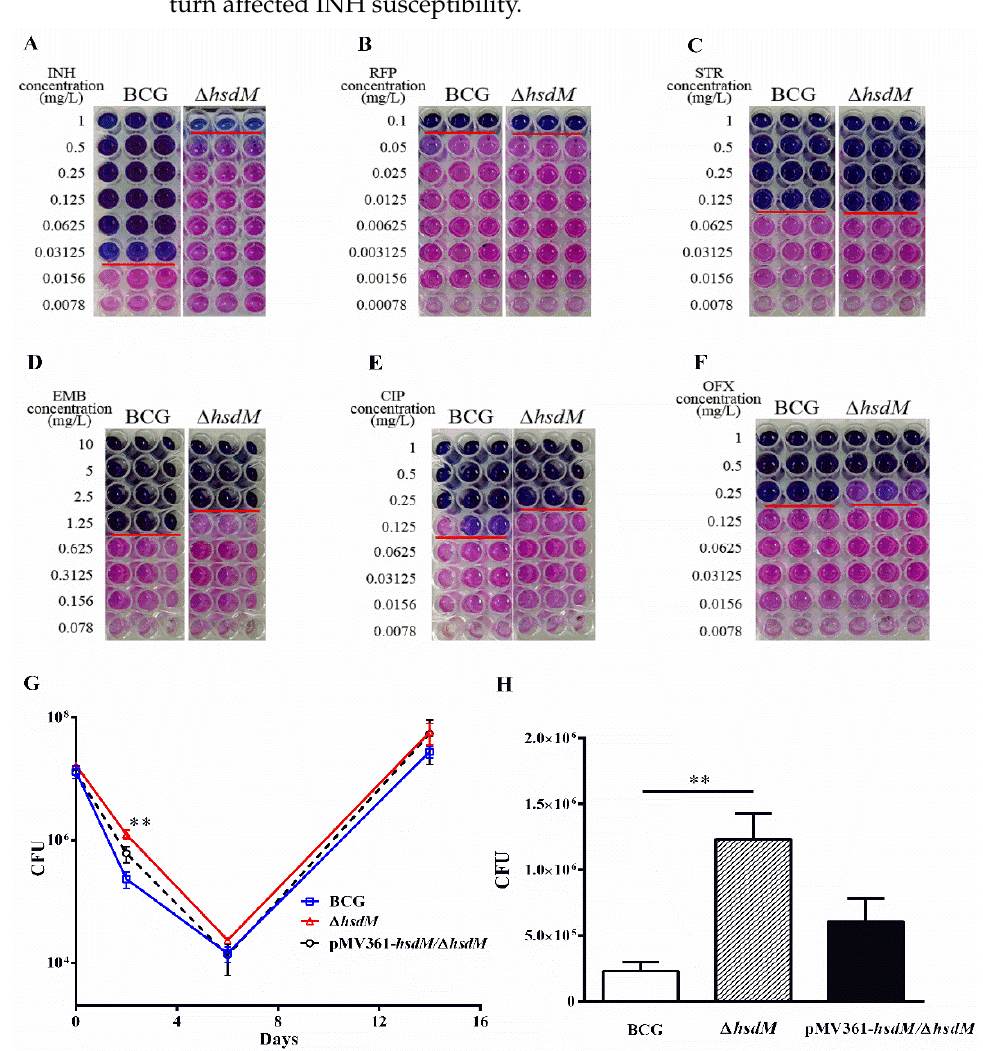
Figure 2. HsdM affected drug susceptibility in BCG. ( A – F ) MICs of INH, RFP, EMB, STR, OFX and CIP on microplates in BCG and ∆ hsdM . Blue wells indicate no growth owing to drug inhibition; pink wells indicate growth. ( G ) Growth curves of BCG, ∆ hsdM and pMV361- hsdM / ∆ hsdM strains treated with 0.25 mg/L INH. ( H ) The number of surviving cells was examined by monitoring the colony-forming units (CFUs) for 2 days. Data are presented as the mean ± standard deviation of three independent replicates. The figure presents the results of three biological replicates. ** p < 0.01.